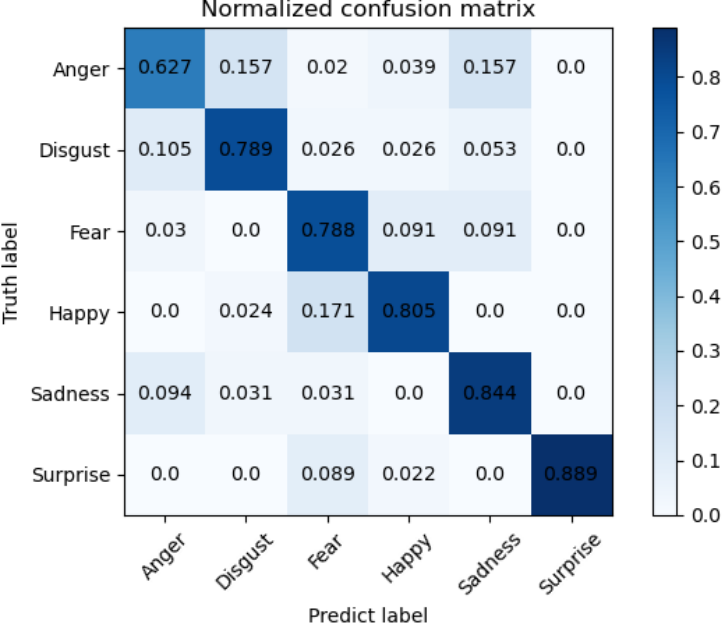
Figure 8. Confusion matrix on 3D-BUFE dataset for six expressions.